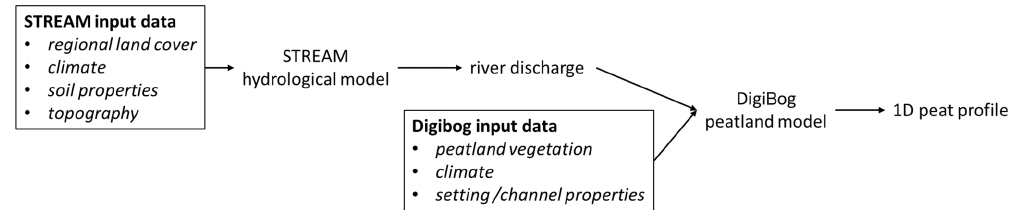
Figure 2. General model workflow. For a more detailed description of the model structure, the reader is referred to the text.